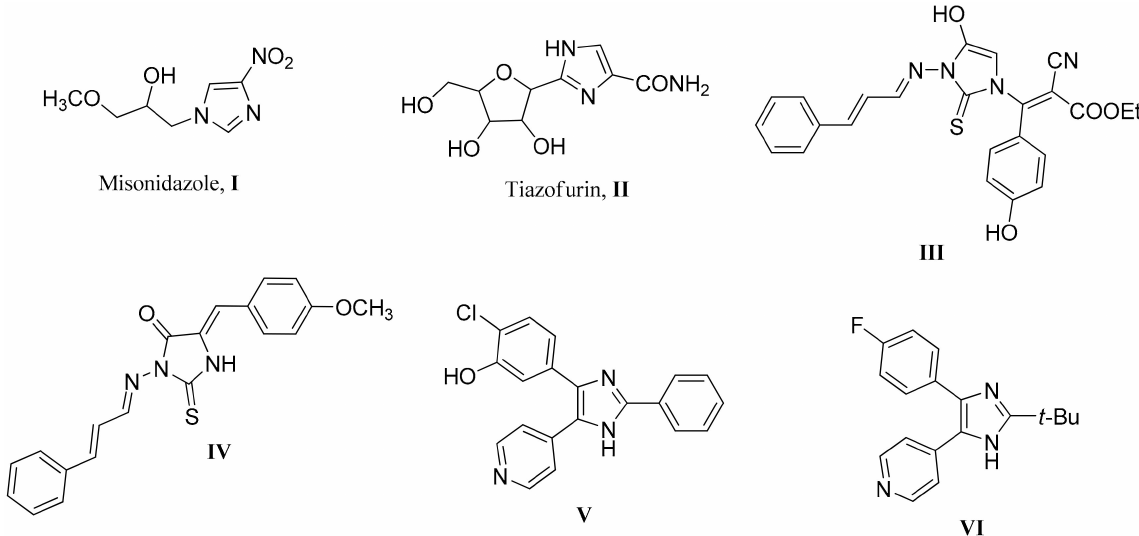
Figure 1. Imidazole derivatives as anticancer